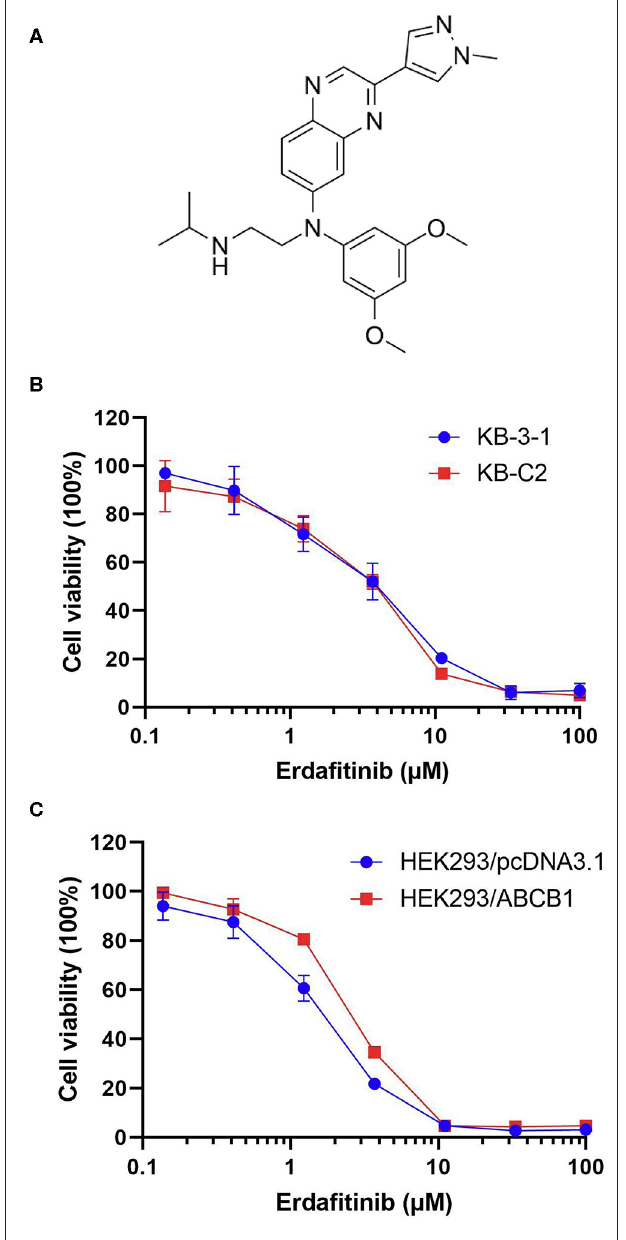
FIGURE 1 | The cytotoxicity of erdafitinib in different cells. (A) The chemical structure of erdafitinib. (B) The cell viability curve of KB-C2 and KB-3-1 cells. (C) The cell viability curve of HEK293/ABCB1 and HEK293/pcDNA3.1 cells. The results are representative of three independent experiments. Error bars indicate